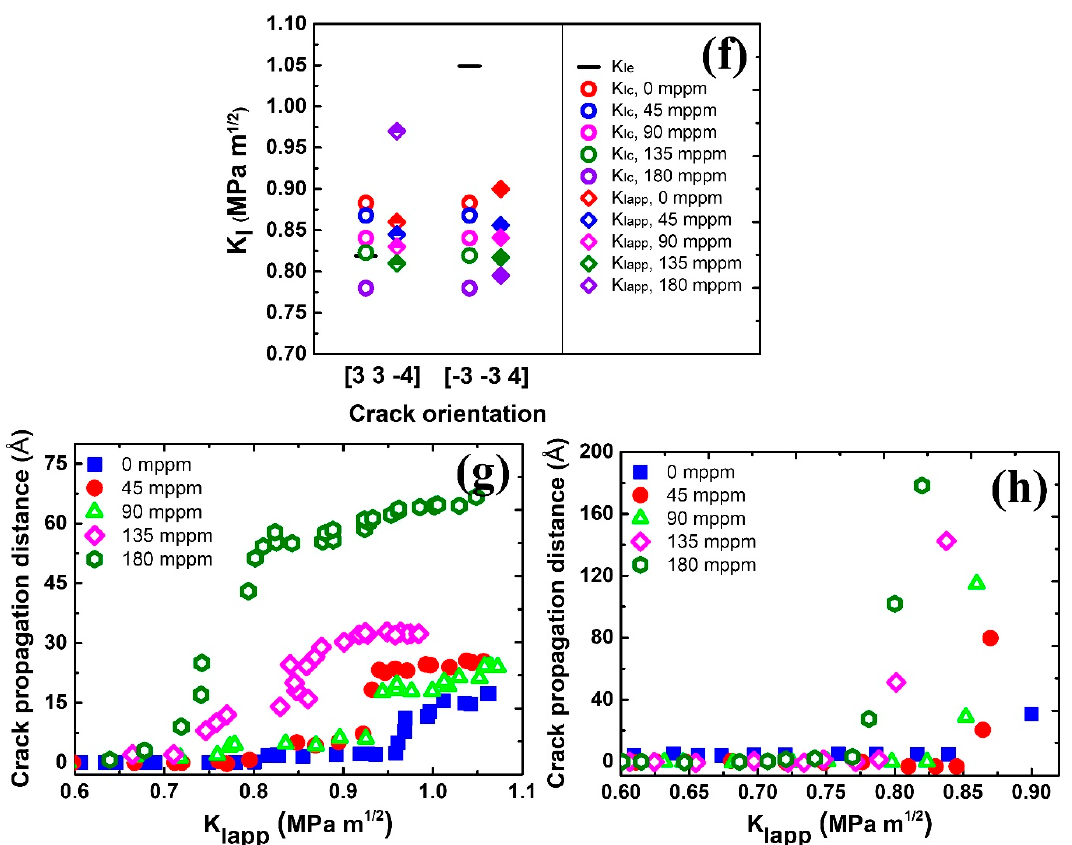
Figure 3. MD snapshots illustrating the crack propagation in the simulations of Σ 17 (2 2 3) GB along ( a ) [ 3 3 4(cid:3364) ] direction with 0 mppm H atoms, ( b ) [ 3 3 4(cid:3364) ] direction with 45 mppm H atoms, ( c ) [ 3 3 4(cid:3364) ] direction with 180 mppm H atoms, ( d ) [ 3(cid:3364) 3(cid:3364) 4 ] direction with 0 mppm H atoms, and ( e ) [ 3(cid:3364) 3(cid:3364) 4 ] direction with 180 mppm H atoms. ( f ) Overview of critical stress intensity factors 𝐾 (cid:3010)(cid:3032) and 𝐾 (cid:3010)(cid:3030) , and the global applied stress intensity factor 𝐾 (cid:3010)(cid:3028)(cid:3043)(cid:3043) in dependence on crack orientation and H concentration. The partially filled diamonds indicate ductile emission, while solid diamonds indicate brittle cleavage. Crack propagation distance versus the stress intensity 𝐾 (cid:3010)(cid:3028)(cid:3043)(cid:3043) with various H concentrations along ( g ) [ 3 3 4(cid:3364) ] direction and ( h ) [ 3(cid:3364) 3(cid:3364) 4 ] direction.